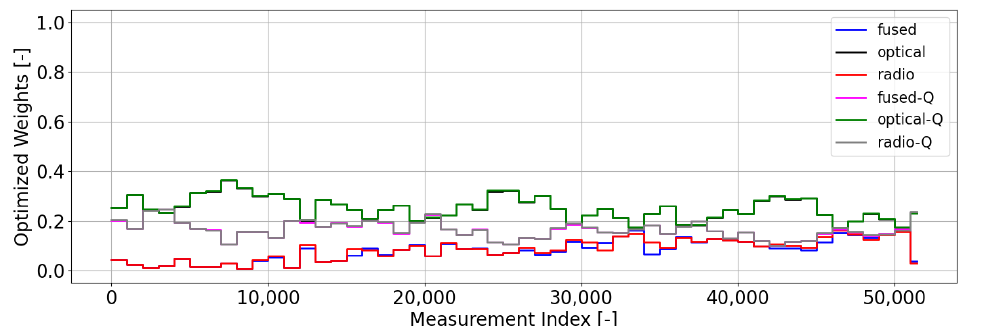
Figure 21. Optimal gating network weights with attitude thruster